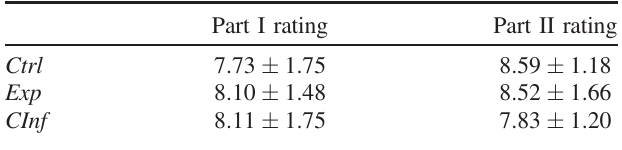
TABLE IV. Average students ’ rating of both parts of the tutorial.